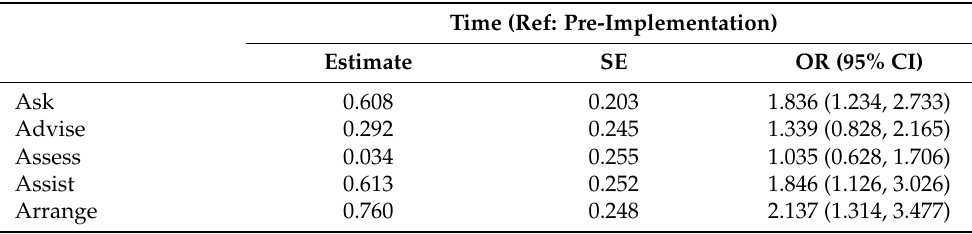
Table 2. Changes in Providers’ Delivery of the 5A’s for Non-cigarette Tobacco Use From Before to After a Comprehensive Tobacco-Free Workplace Program Implementation (N = 15